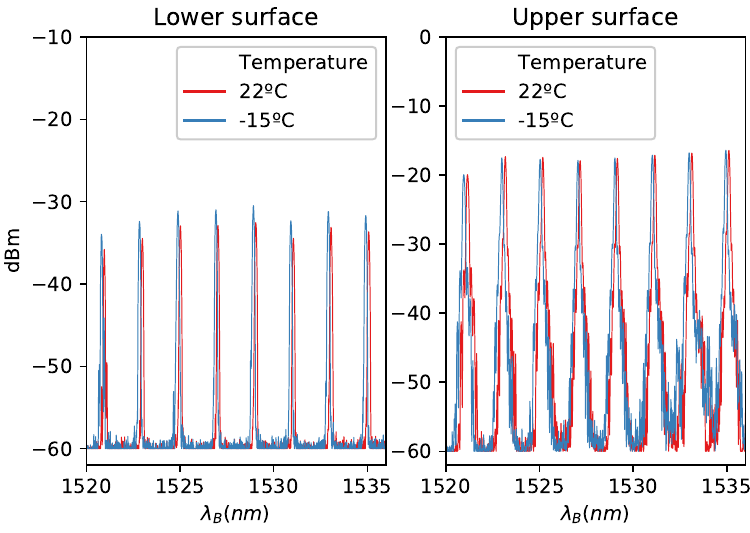
Figure 1. Spectral response of the sensor for two different